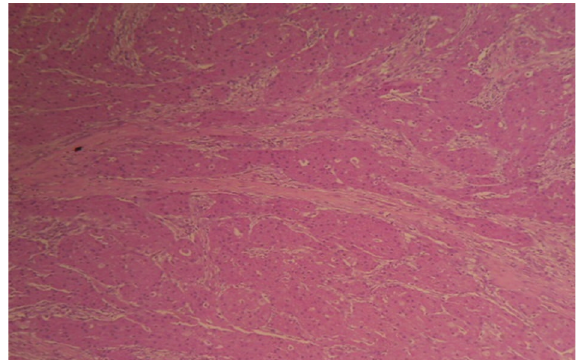
Figure 4: Tumor cells showing di ff use strong immunostaining for S-100 protein ( × 40).